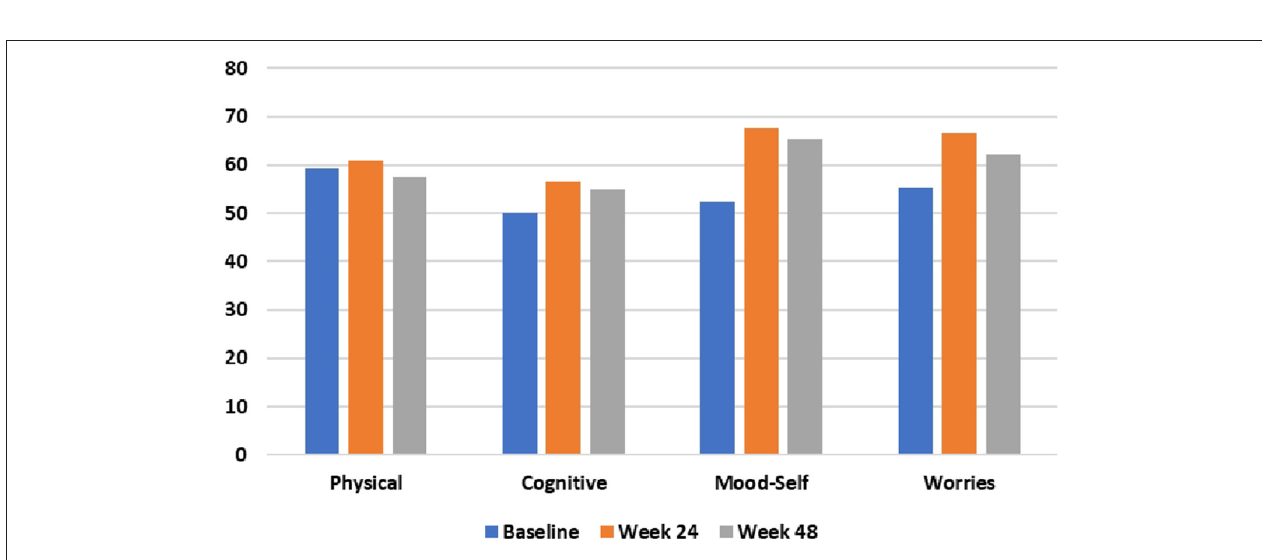
FIGURE 3 | HD health-related Quality of Life (HDQoL) outcomes at baseline, 24 weeks, and 48 weeks after commencing the time-restricted ketogenic diet (higher numbers indicate improved quality of